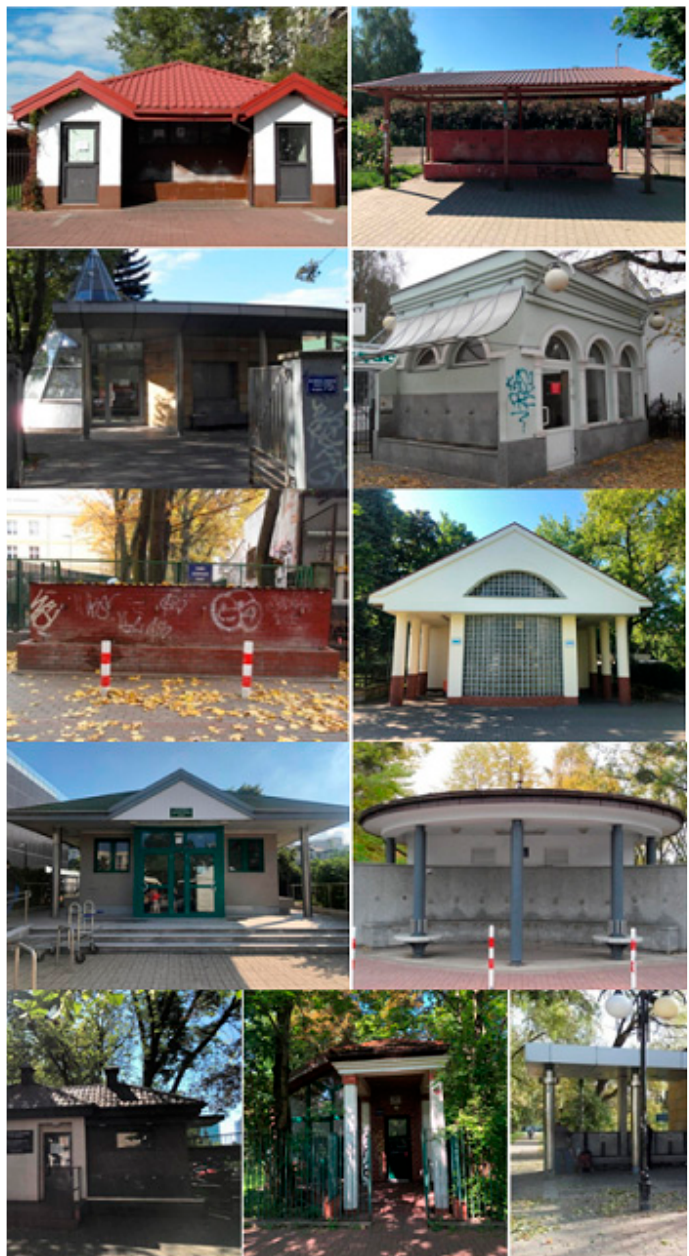
Figure 1. Oligocene water intakes included in the study. In order to confirm the presence of E. coli in the water, the material taken from the yellow-colored colonies obtained on the surface of the filter was transferred to lactose bril- liant green bile broth (Merck Polska, Warsaw Poland) and peptone broth with tryptophan (Merck) (medium for detecting the indole-producing bacteria). The cultures were then incubated for 24 h at 44 ◦ C. The presence of gas, indicating the occurrence of a lactose fermentation reaction on the brilliant green bile broth and the presence of indole formed from tryptophan with the participation of bacteria, wastaken as a positive result. The results for coliforms and fecal enterococci were reported as the number of CFU/100 cm 3 of